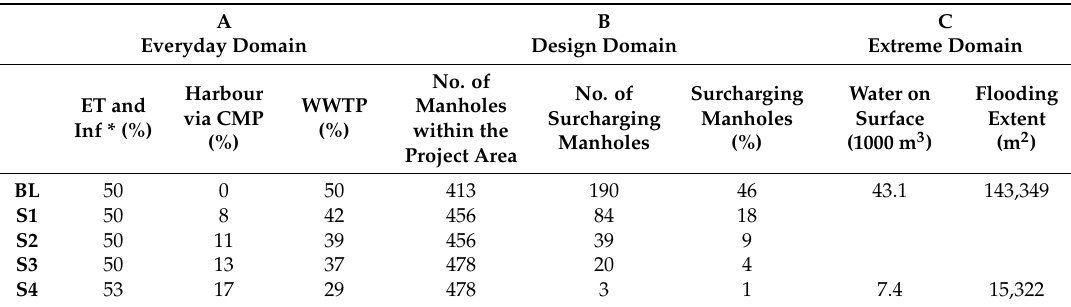
Figure 4. Total water balance for the different scenarios for one year of continuous simulation (2003); ET stands for evapotranspiration, Inf for infiltration, WWTP for wastewater treatment plant, and CMP for cloudburst management plan. Table 2. System performance summarised for each scenario and each domain of the Three Point Approach (3PA).